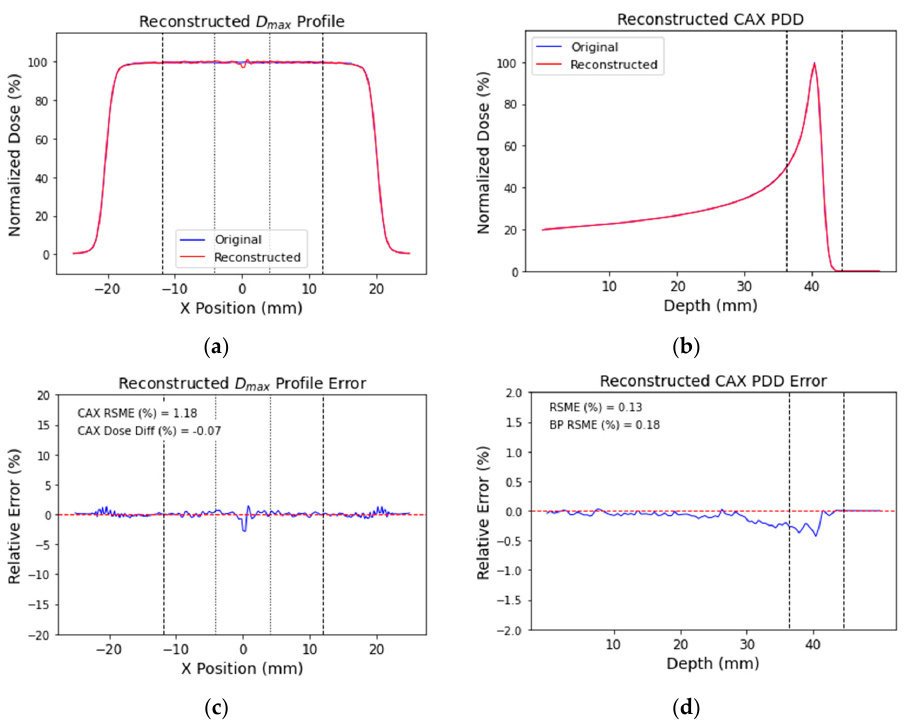
Figure 6. No-noise simulation reconstructed Dmax profile and CAX PDD accuracy. The recon- structed profile at D max ( a ) and CAX PDD ( b ) are compared with the MC-simulated distribution profile and PDD and the resulting percentage error in the profile ( c ) and PDD ( d ). The CAX region (dotted lines) and beam region (dashed lines) on the profile and the Bragg Peak region (dashed lines) for the PDD are indicated.